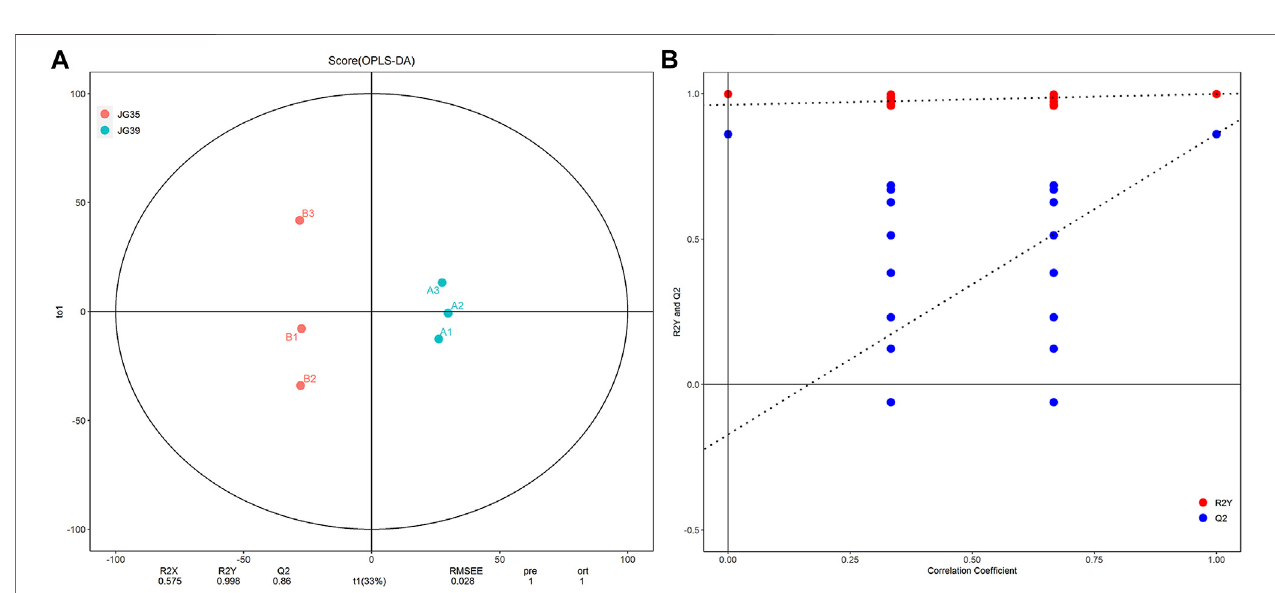
FIGURE 3 | Multivariate statistical analysis of lipid molecules. (A) The Score chart of OPLS-DA. (B) Model validation diagram of OPLS-DA.